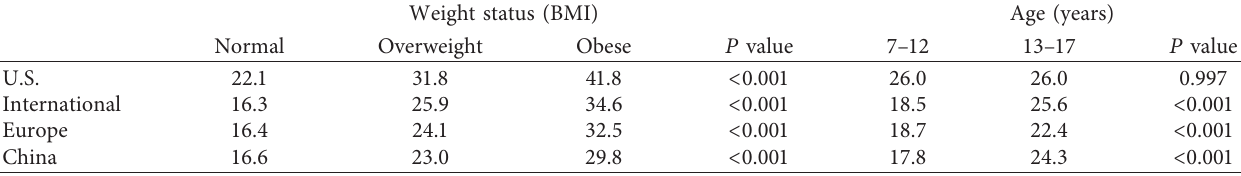
Table 1: Prevalence of high blood pressure (%) in the study population based on the 4 reference systems stratified by weight status or age.